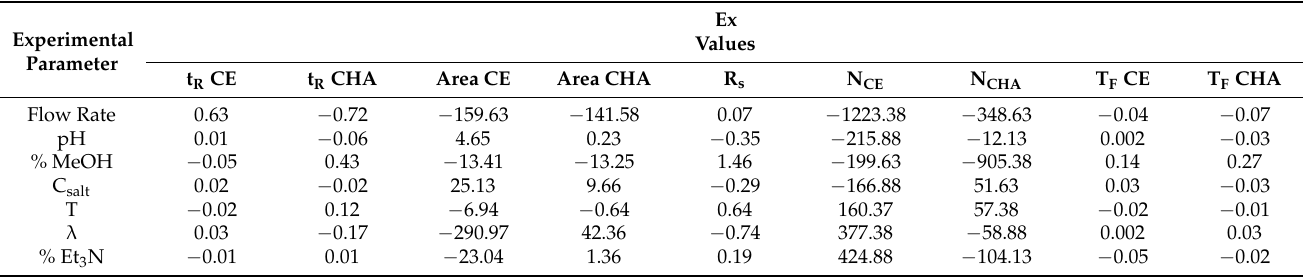
Table 7. Effects of each factor to the respective responses.